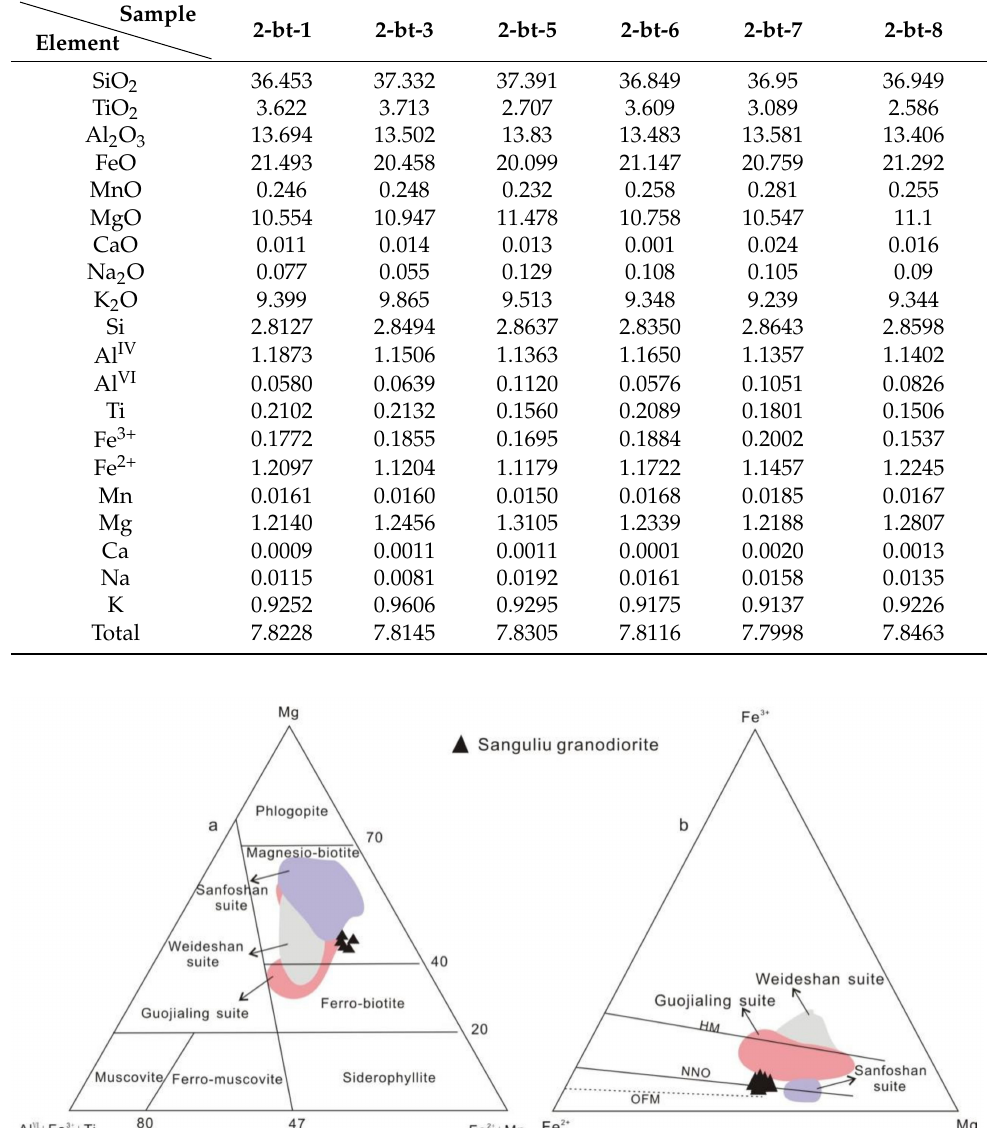
Figure 12. Diagrams of classification (( a ), modified from [66]) and Fe 3+ –Fe 2+ –Mg (( b ), modified from [67]) of the biotites from the Sanguliu, Guojialing, Weideshan, and Sanfoshan plutons. The data of EPMA biotite compositions are from [23,68] and this paper,